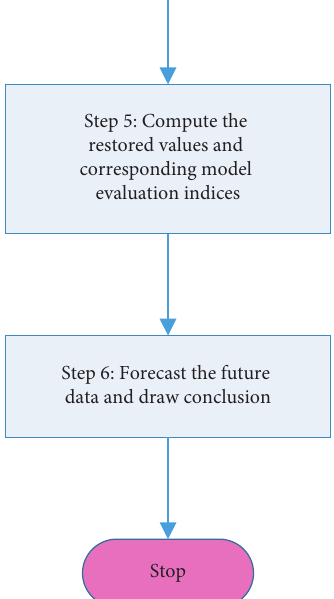
Figure 1: The flowchart of the novel model by